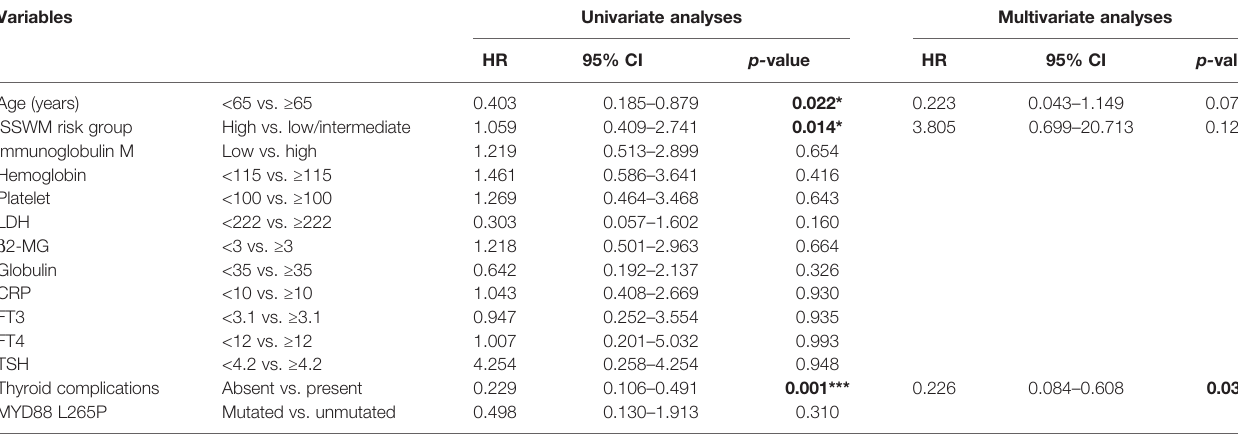
TABLE 5 | Univariate and multivariate Cox regression analyses of progression-free survival (PFS) in WM/LPL patients. Variables